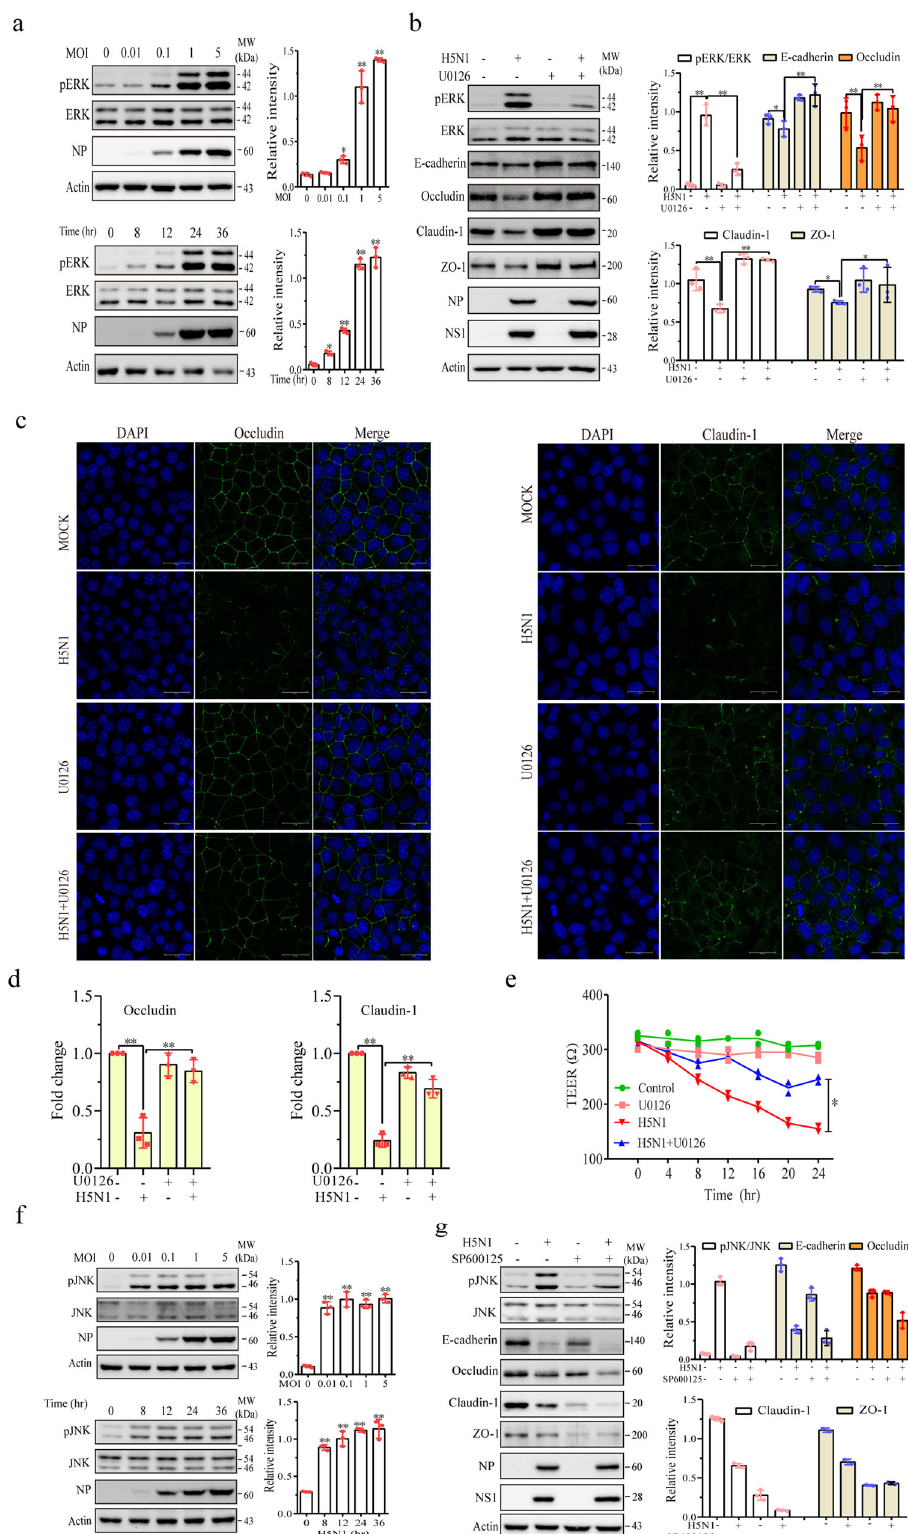
reversed by U0126 (Fig. 5d). The TEER assay revealed that infected A549 cells (Fig.